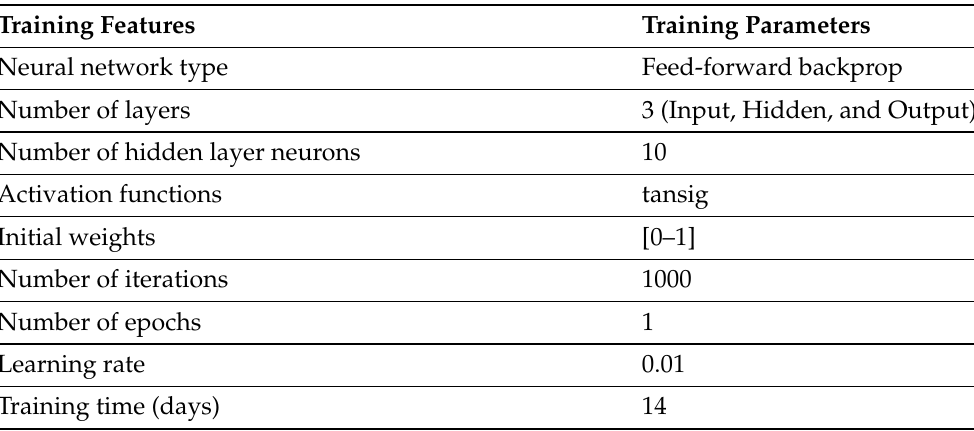
Figure 6. Illustration of the proposed neural network architecture. Table 3. The training